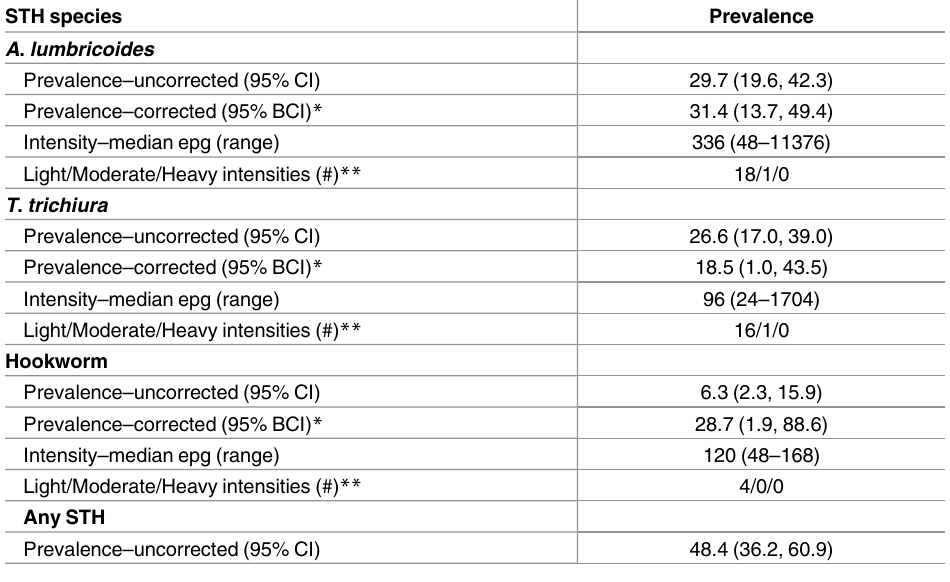
Table 2. Baseline prevalenceand intensity of soil-transmitted helminth infections as assessedby sin- gle stool specimens collected in the hospital (n = 64) and analyzed using the Kato-Katz technique, Iquitos, Peru (February–August